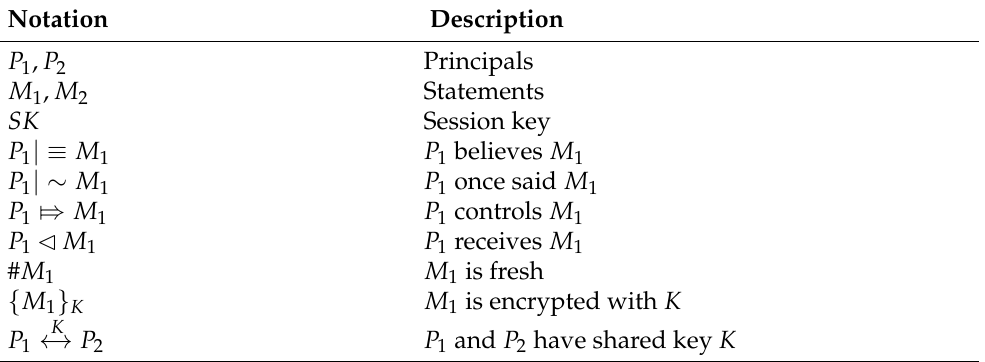
Table 2. Notations of BAN